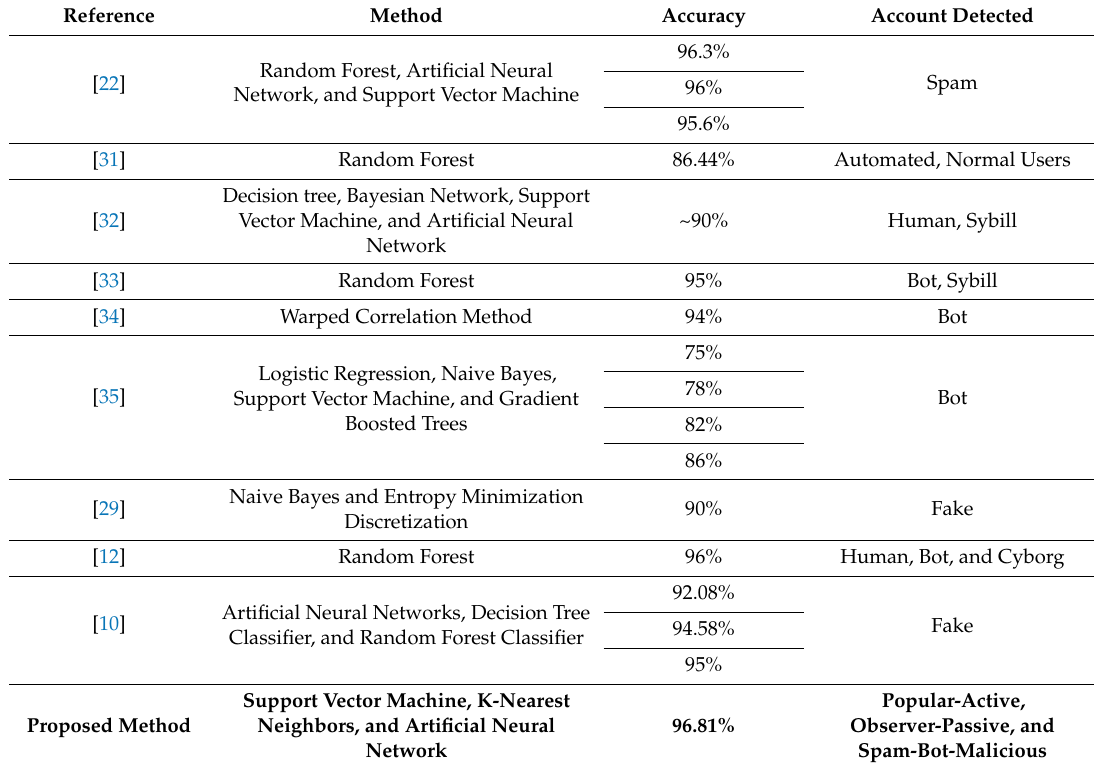
Table 7. Methods and success rates of studies in the